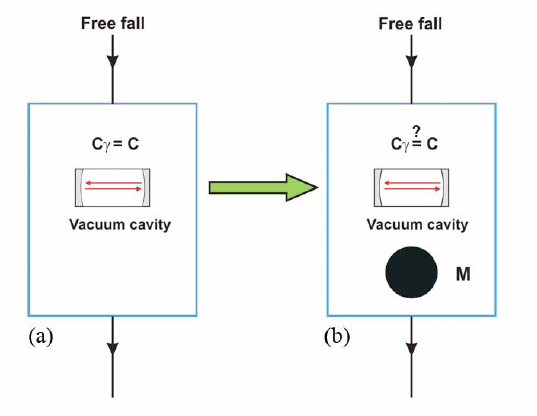
Figure 10. An intuitive visualization of two physically distinct situations. In case ( b ), a heavy mass M is carried on board of a freely falling system. Unlike in the ideal case ( a ), the mass M could introduce a vacuum refractivity so that c γ (cid:54) = c